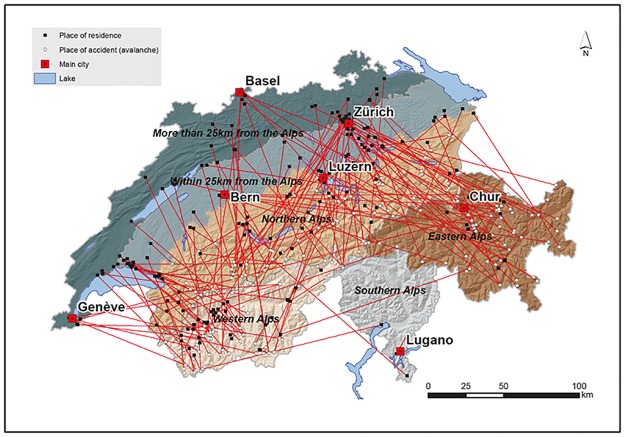
Map of Switzerland illustrating the regional variable and places of residence and of avalanche accidents.